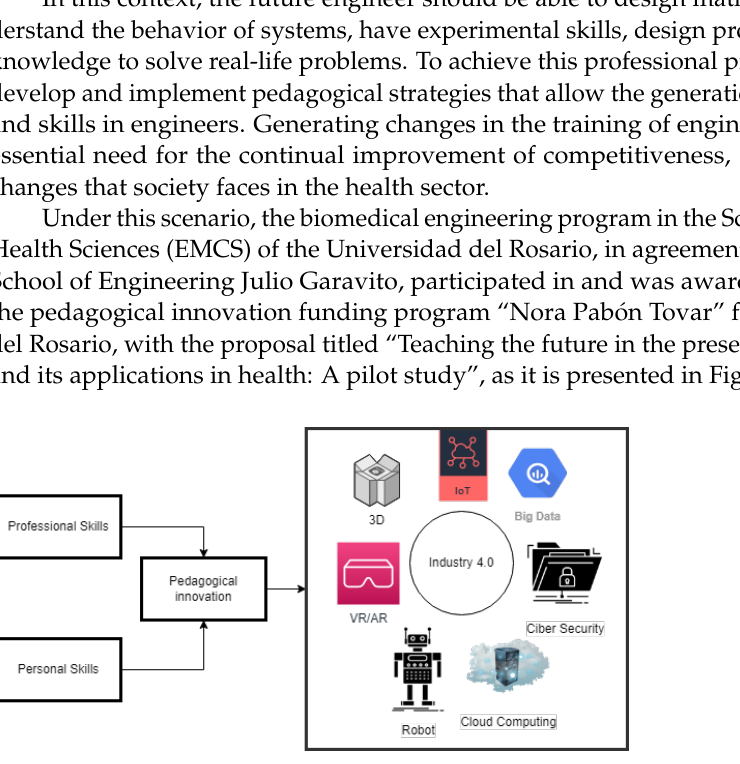
Figure 1. Personal and professional skills through educational